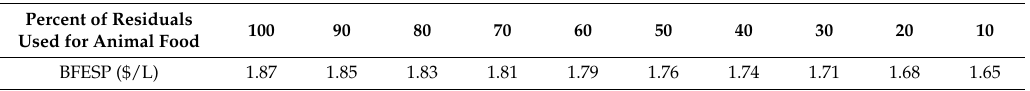
Table 2. BFESP (breakeven fuel ethanol selling price), when the stated percentage of the residuals is used as animal feed *.